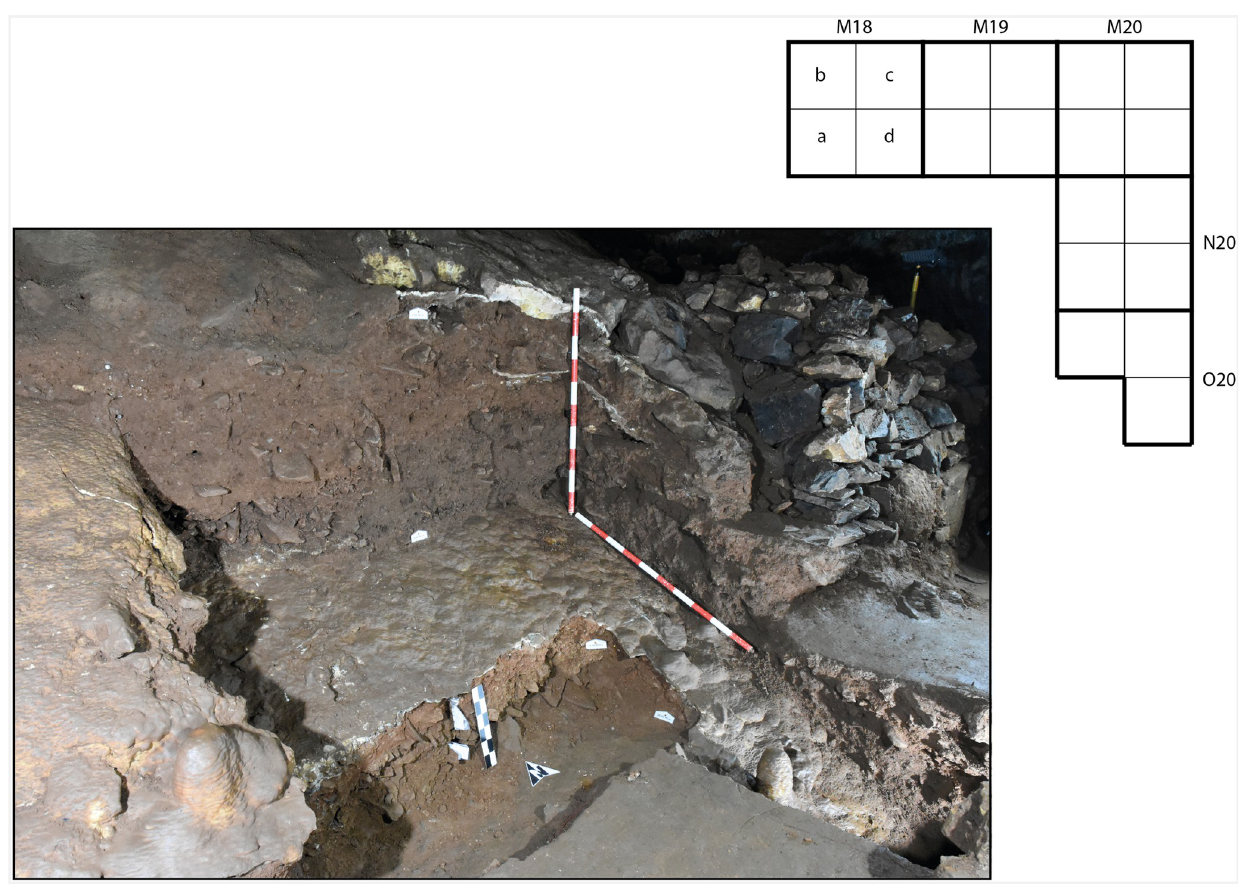
Fig 5. Post-excavation view of zone 2. The plan shows the arrangement of the excavation